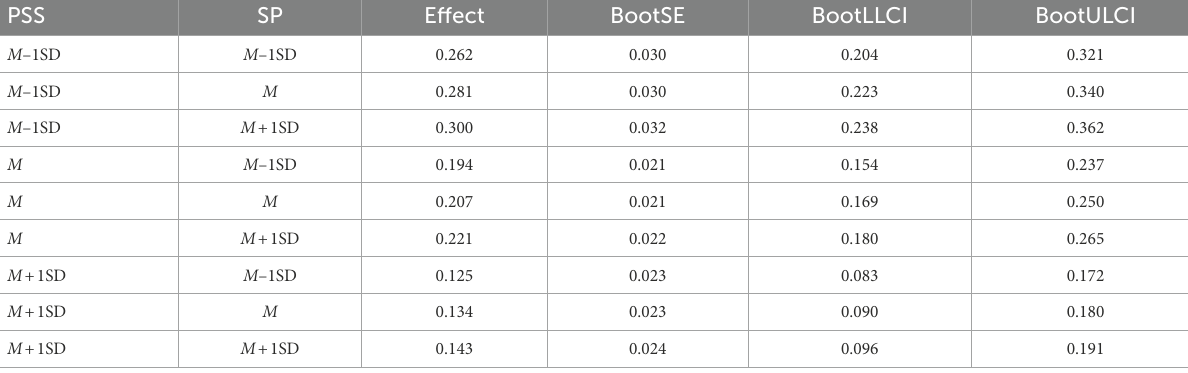
TABLE 6 Mediating effects of anxiety on different moderated levels of PSS and